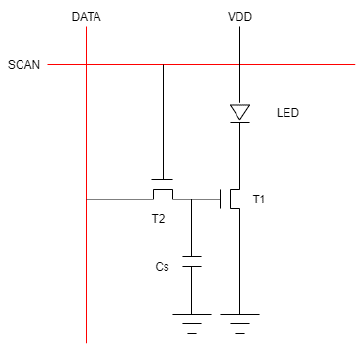
Figure 11. Structure of the 2T1C driving circuit.